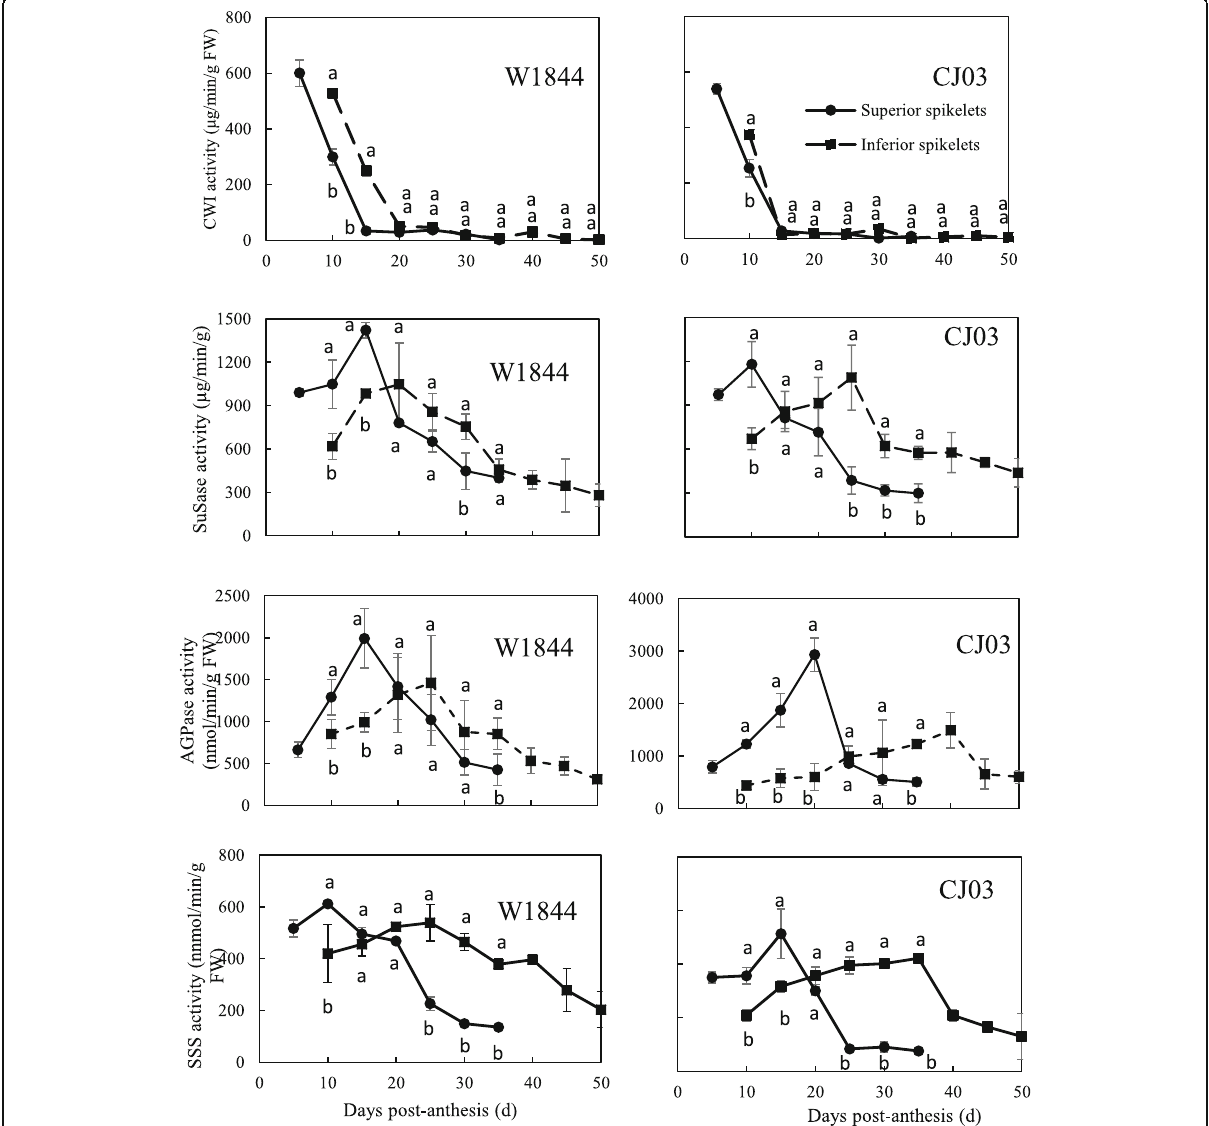
Fig. 8 Changes in enzyme activity related to sucrose-starch metabolism in spikelets of W1844 and CJ03 during the grain filling stage. Values are means ± SE ( n = 30). Different letters indicate statistically significant differences at the P = 0.05 level by Duncan ’ s